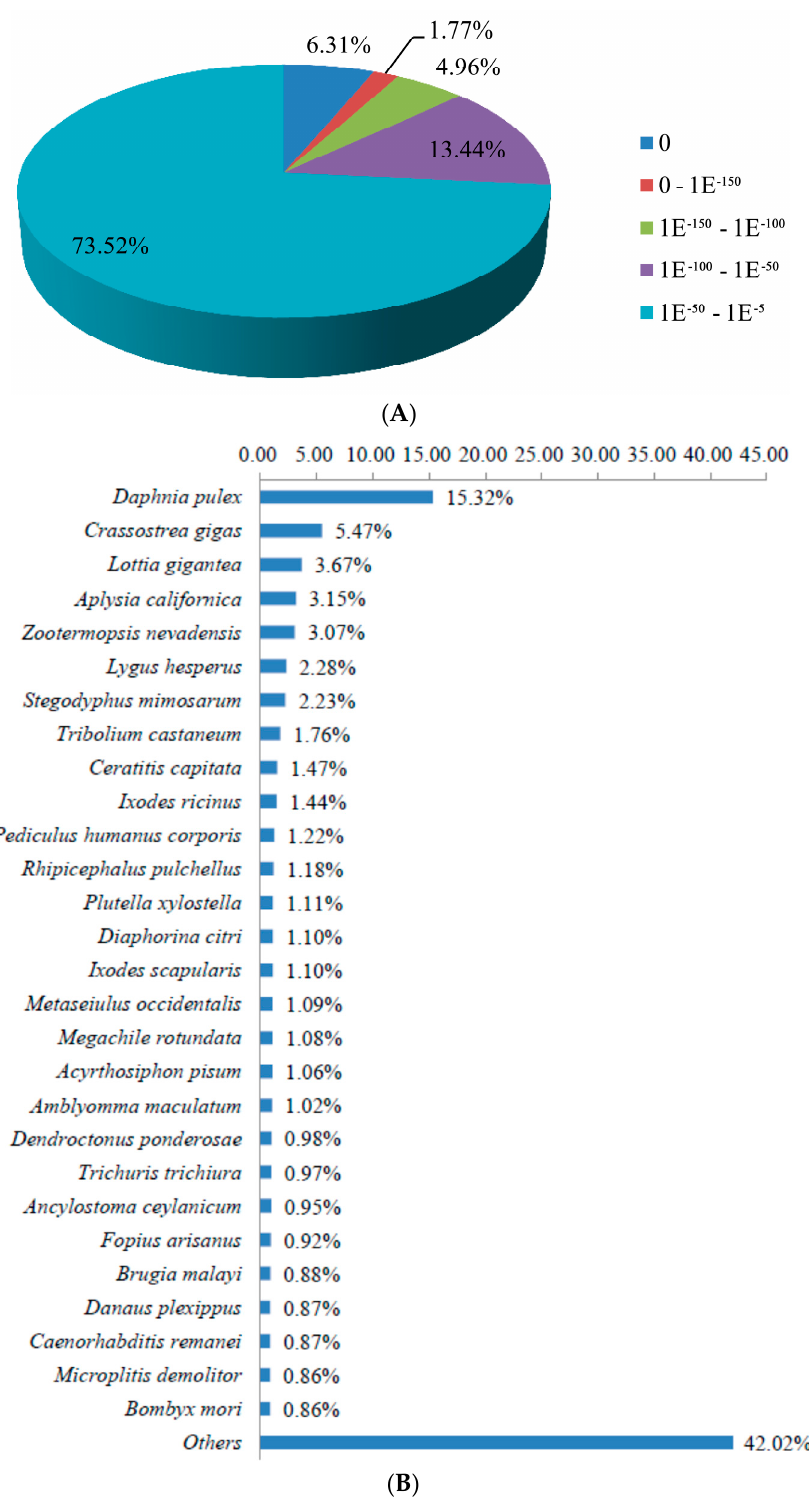
Figure 3. Homology searches of T. longicaudatus unigenes against the PANM ‐ DB. ( A ) E ‐ value distribution; ( B ) Top ‐ hit species distribution.